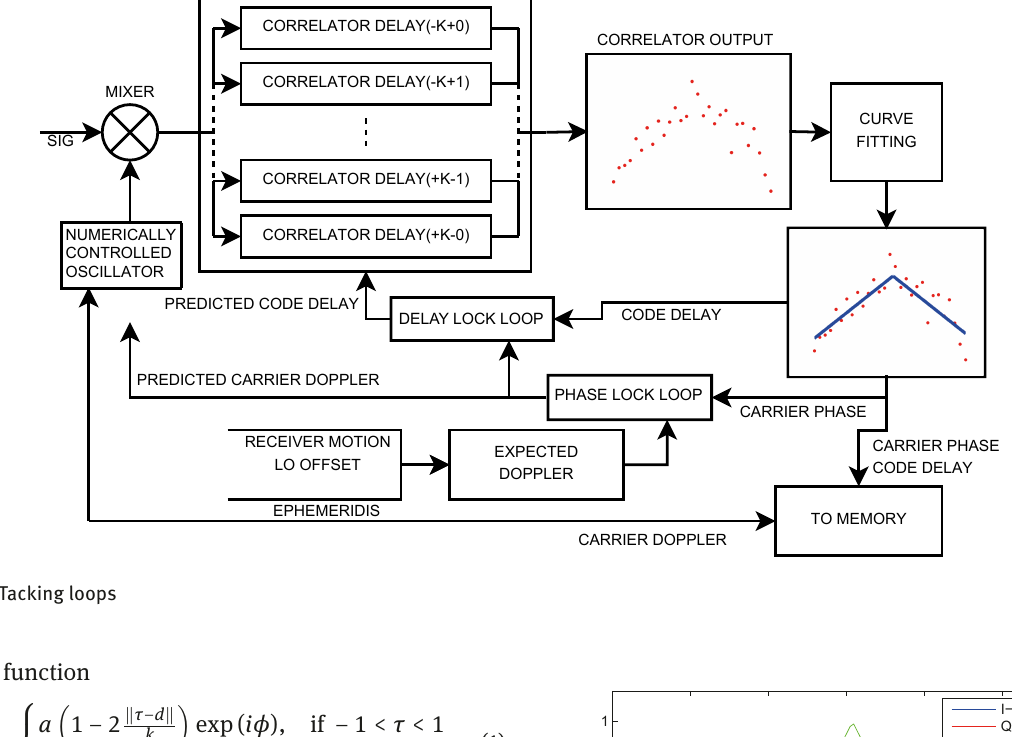
relation function